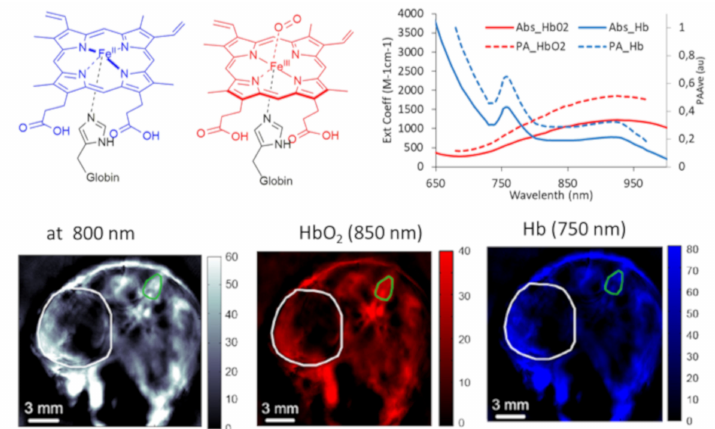
Figure 3. Top: Chemical structures of oxy / deoxy protoporphyrins and their UV-vis / PA spectral overlay (UV-vis data obtained from open source, OMLC.org). Bottom: PA tomographic image of prostate cancer (PC-3) tumor bearing mice (big circle region; small circle: healthy tissue) HbO 2 and Hb of air breathing mouse (z-scales: arbitrary units). Reproduced from Reference [63] under license https: // creativecommons.org / licenses / by / 4.0 /